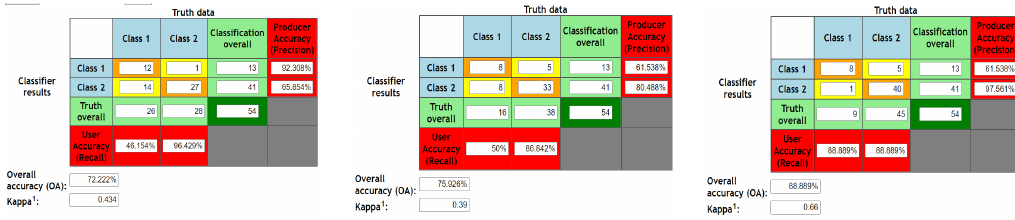
Figure 7. Confusion matrix for Validation phase of 3D Doppler images for SVM, LSTM and VAE-CNN